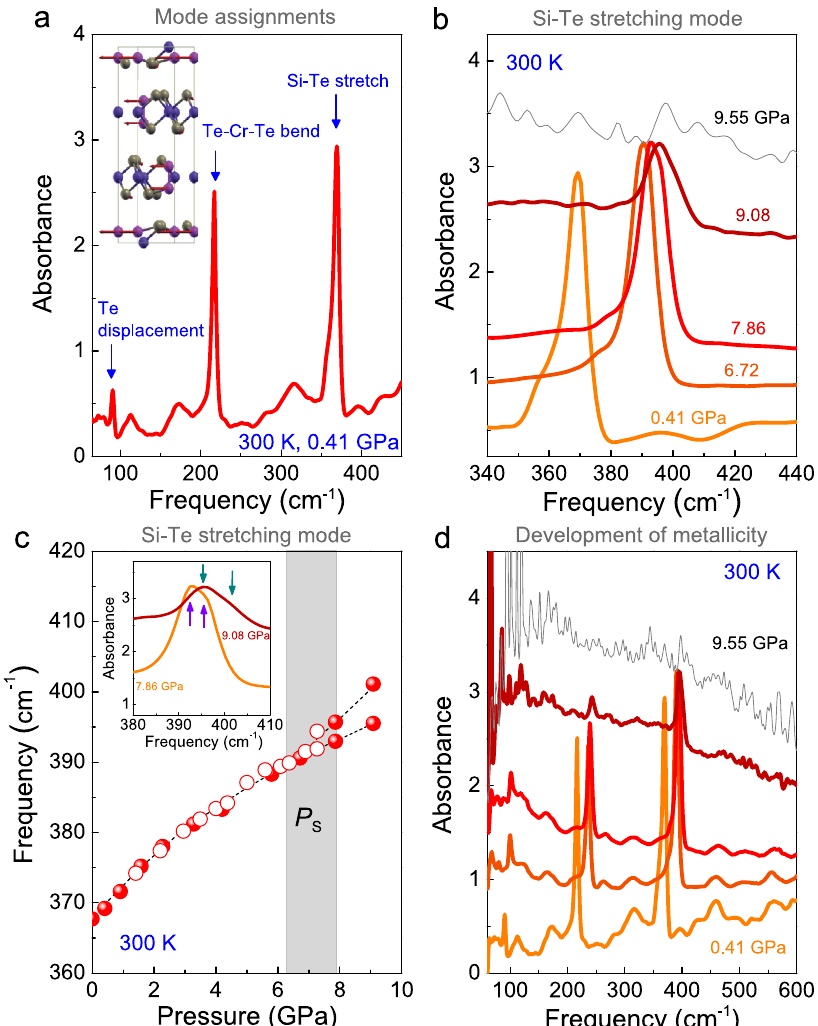
Fig. 1 Infrared response of CrSiTe 3 under pressure. a Infrared spectrum of CrSiTe 3 inside the diamond anvil cell at 300 K. Based upon an R 3 space group, this van der Waals material hosts three infrared-active phonon modes. The 368 cm − 1 Si – Te stretching mode is strongly coupled to the 33 K ferromagnetic ordering transition 23 . Inset: calculated displacement pattern for the Si – Te stretching mode at 368 cm − 1 reproduced from ref. 23 . This displacement modulates the Te centers in the 90 ∘ Cr – Te – Cr superexchange pathway. b Close-up view of the Si – Te stretching mode showing the development of the fi rst-order structural phase transition, the rising absorption background, and metallicity. c Frequency vs. pressure plot of the Si – Te stretching mode at room temperature. The closed and open symbols correspond to two different runs. The mixed phase region associated with the structural phase transition is indicated in gray. Inset: close-up view of the Si – Te stretch showing the development of doublet character due to the presence of two coexisting phases. d Spectral evidence for the insulator – metal transition due to closure of the indirect gap near 9.55 GPa (indicated in gray). The spectra are on an absolute scale; they are not shifted in any way. Complementary re fl ectance data are shown in the Supporting